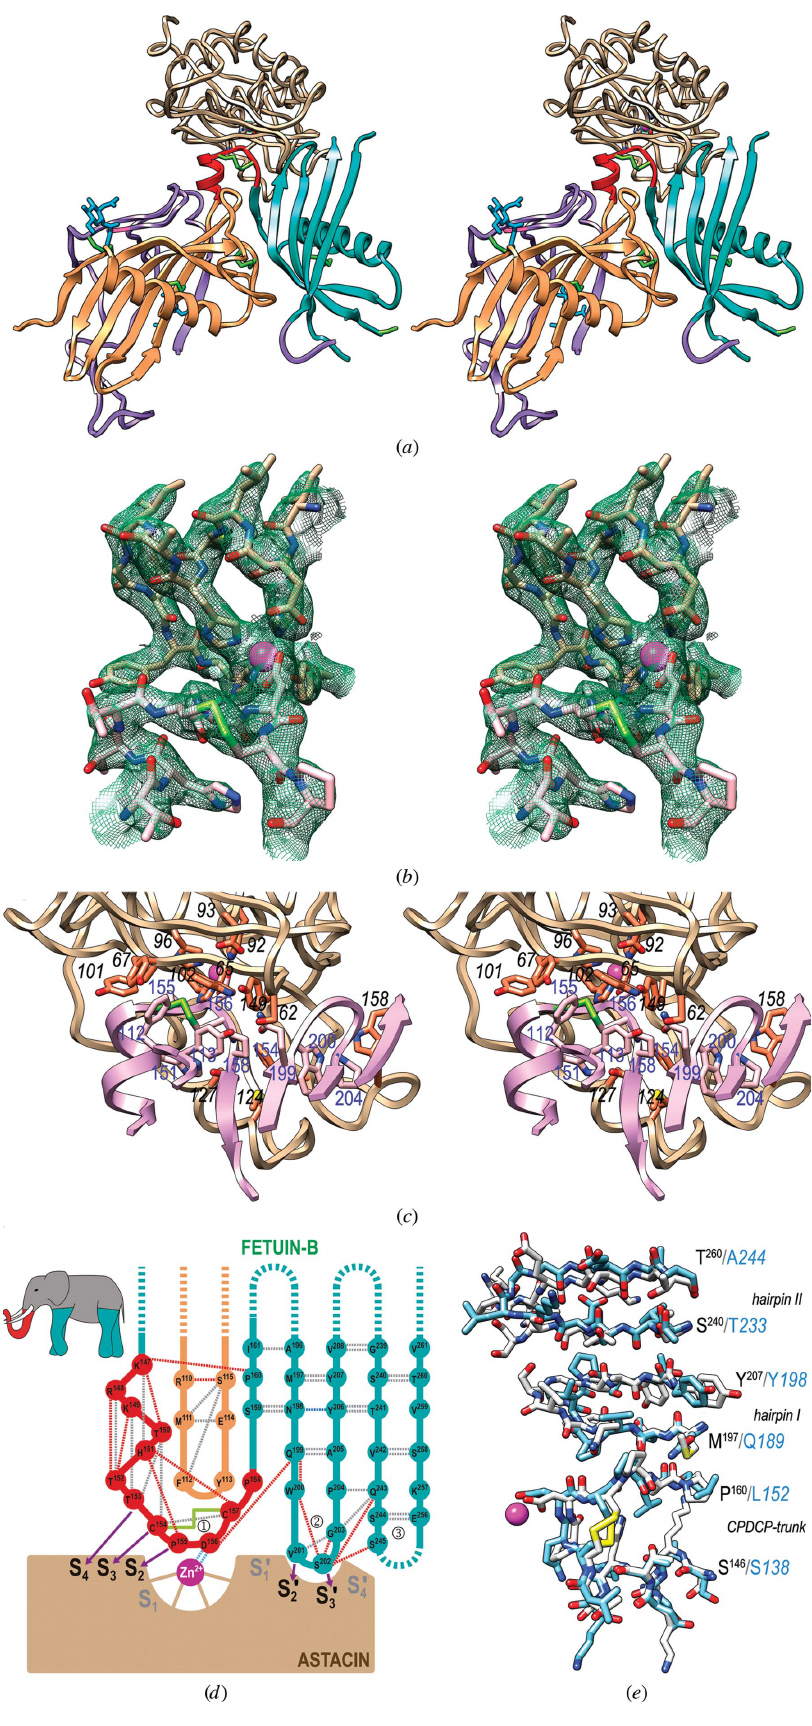
Figure 2 The astacin–fetuin-B complex. ( a ) Cross-eyed stereo cartoon displaying fetuin-B [colors as in Fig. 1( b )] inserted into the active-site cleft of astacin (tan ribbon). The MP is shown after a horizontal (cid:7) 90 (cid:3) rotation downwards from the traditional standard orientation of MPs (Gomis-Ru¨th, Botelho et al. , 2012), so the cleft runs from left (nonprimed subsites) to right (primed subsites). The catalytic zinc is shown as a magenta sphere and its astacin ligands as stick models, as are P 155 and D 156 from fetuin-B. ( b ) Detail of the final (2 mF obs (cid:4) DF calc )- type Fourier map at 3.1 A˚ resolution contoured at 1 (cid:5) above the threshold, depicting the zinc-binding site of astacin (carbons in tan, zinc ion as a magenta sphere) and the CPDCP-trunk of fetuin B (carbons in pink). ( c ) Close-up view of ( a ) after a horizontal 35 (cid:3) rotation, displaying selected residues partici- pating in the interaction between fetuin-B (C (cid:2) ribbon in plum; from left to right, segments S 146 – D 162 , M 111 –E 114 , N 197 –Y 206 and T 241 –S 245 ; carbons in pink and residue numbers according to UniProt Q9QXC1 in blue) and astacin (C (cid:2) ribbon in tan, carbons in orange, catalytic zinc as a magenta sphere and residue numbers in black italics according to UniProt P07584). The C 154 –C 157 disulfide from the CPDCP-trunk of fetuin-B is shown with green sulfurs. ( d ) Scheme of the proposed ‘raised elephant-trunk model’; the view mirrors that in ( a ) and ( b ). The CPDCP-trunk ( (cid:6) 1 ) would be the raised trunk (in red) and hairpin I ( (cid:6) 2 ) and II ( (cid:6) 3 ) the two front and back limbs (in turquoise), respectively (see top-left inset). The trunk contacts the catalytic zinc ion (magenta sphere) of astacin (in brown) by residues nestling into cleft subsites S 4 , S 3 , S 2 , S 2 000 and S 3 000 , as shown by purple arrows. Dashed lines represent distantly connected segments or disor- dered loops. Hydrogen bonds between main-chain atoms, between side-chain and main-chain atoms, and between side-chain atoms are shown as gray, red and blue dashed lines, respectively. The electro- static interaction between the catalytic zinc and D 156 is in light blue. The disulfide connecting the CPDCP-trunk is shown as a green solid line. ( e ) Superposition of the experimental structure of mouse fetuin-B (white carbons and black labels) and the comparative model of human fetuin-A (cyan carbons and blue labels with regular residue numbers in italics) depicting the regions of the CPDCP warhead and the tips of hairpins I and II of each structure. The view results from ( c ) after a 90 (cid:3) rotation in the plane. The catalytic zinc ion of astacin is further shown as a magenta sphere for